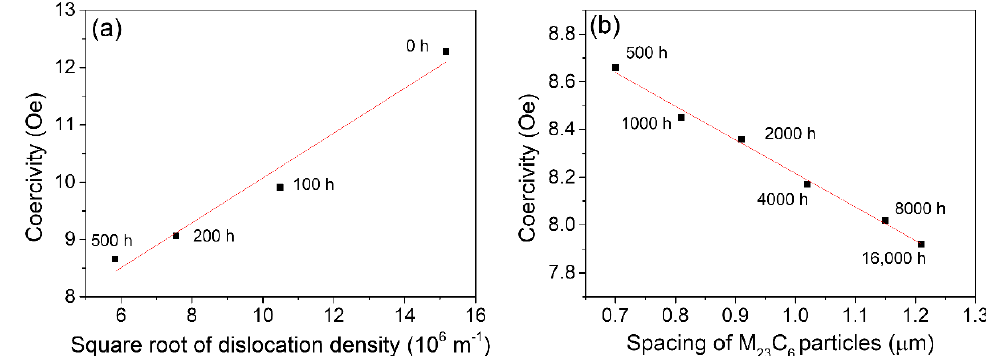
Figure 7. ( a ) Dependence of coercivity on the square root of dislocation density during the early aging stage (<500 h); ( b ) dependence of coercivity on the spacing of M 23 C 6 precipitates at the aging stage beyond 500 h.